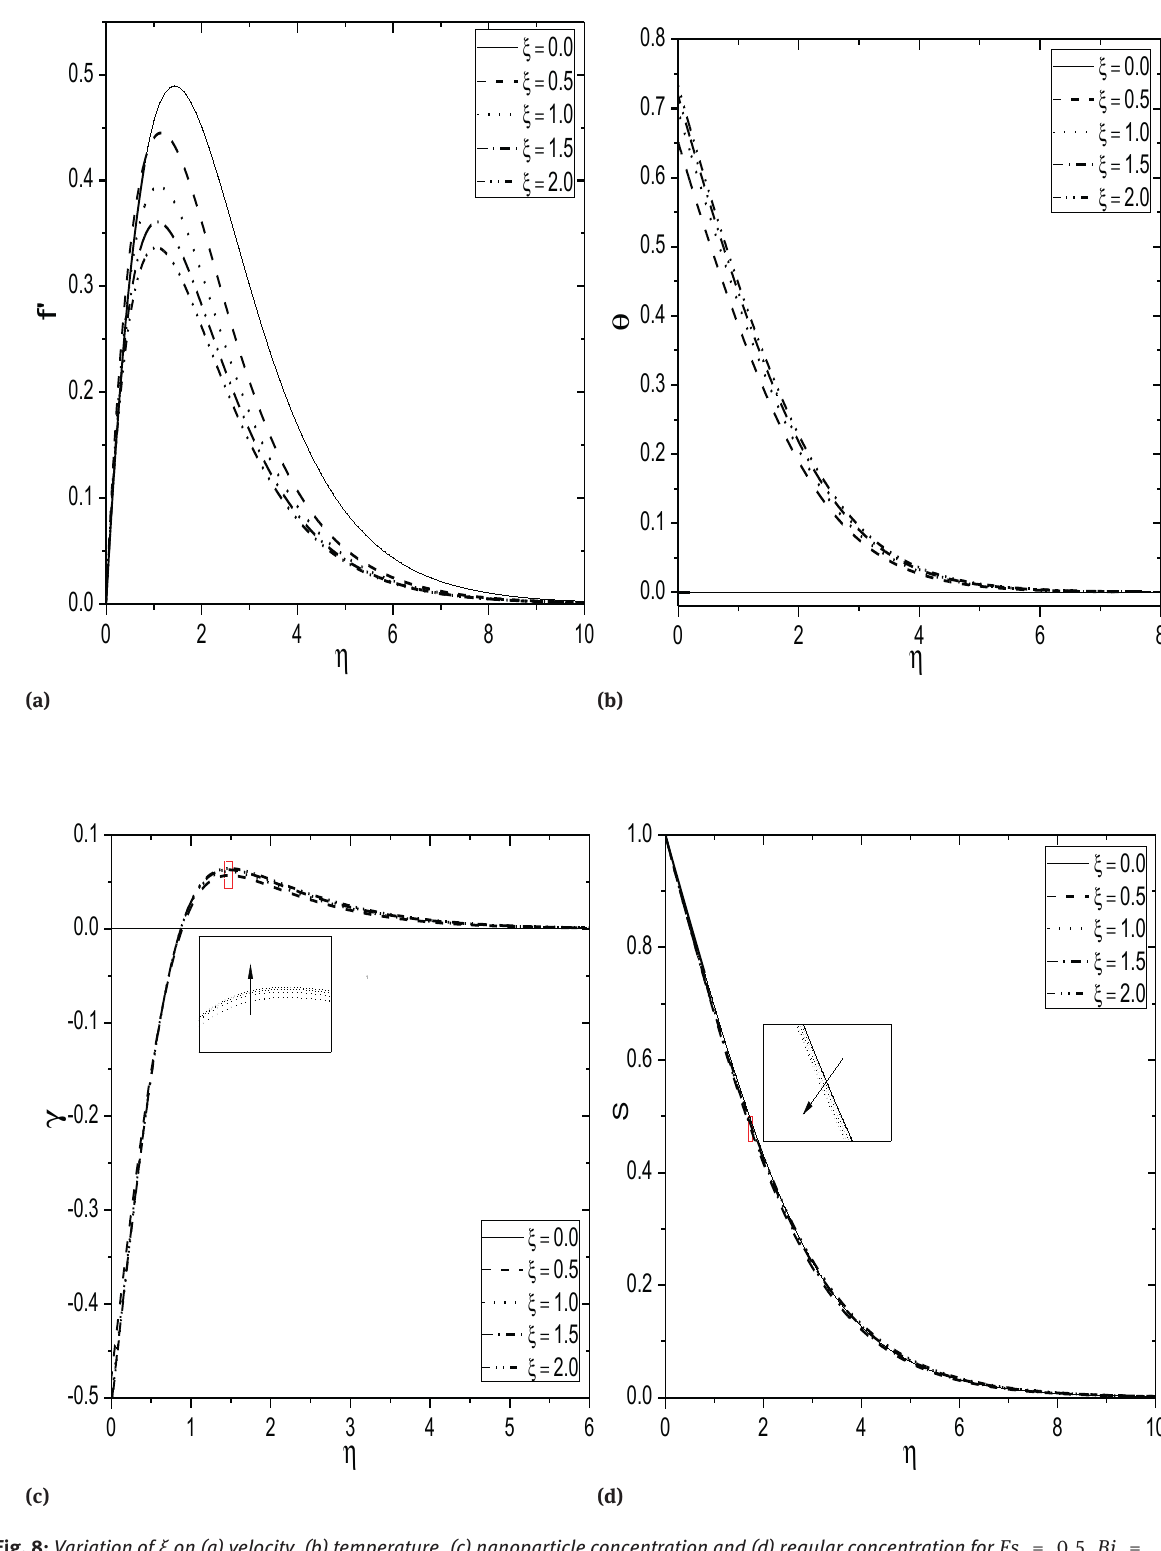
Fig. 8: Variation of ξ on (a) velocity, (b) temperature, (c) nanoparticle concentration and (d) regular concentration for Fs = 0.5, Bi = 1.0, Ds = 0.2, Dc = 0.3